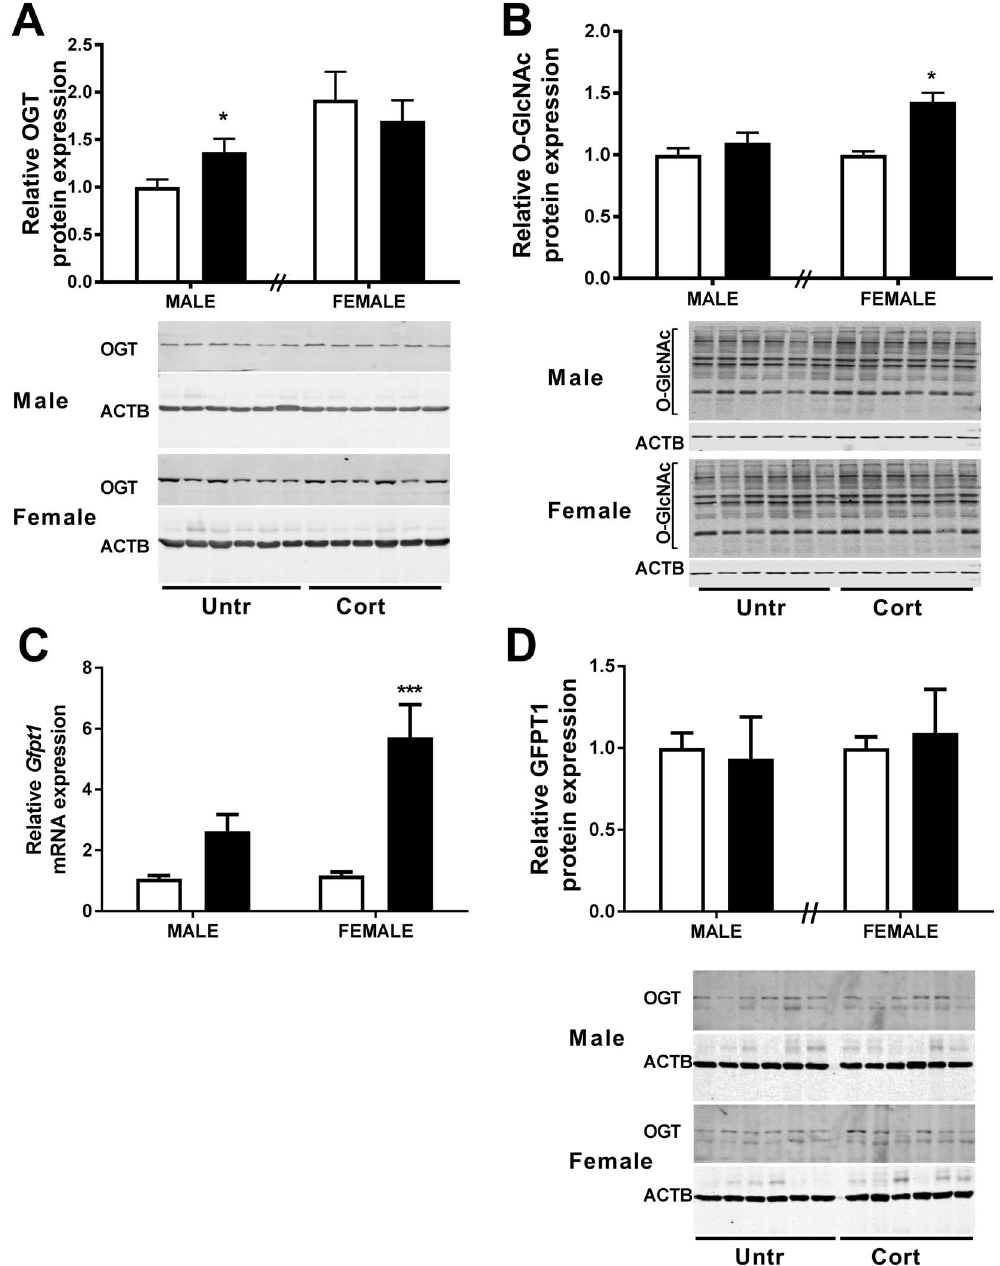
Figure 3. The effects of corticosterone exposure (black bars) on ( A ) O-linked β -N-acetylglucosamine transferase (OGT) relative protein expression and ( B ) levels of O-linked N-acetylglucosamine (O-GlcNAc) modification on cellular proteins in whole placentae of both male and female C57/BL6 fetuses at E14.5 compared with untreated controls (white bars). ( C ) shows glutamine-fructose-6-phosphate-transaminase 1 (GFPT1) relative mRNA and ( D ) GFPT1 protein expression in the same tissues. Data represents mean + SEM, * P < 0.05, **** P < 0.0001 for post hoc analysis or t- test results. Real-time quantitative PCR used to determine gene expression, and normalised to the average of two housekeeping genes. RNA data were analysed using a two-way ANOVA comparing the factors treatment and sex with Bonferroni’s post hoc testing presented on graph (n = 9–11). Protein expression was examined by western immunoblot with β -Actin (ACTB) as loading control, normalised to untreated control of the same sex. Protein expression was analysed using a two-tailed t- test with untreated controls of the same sex (n =